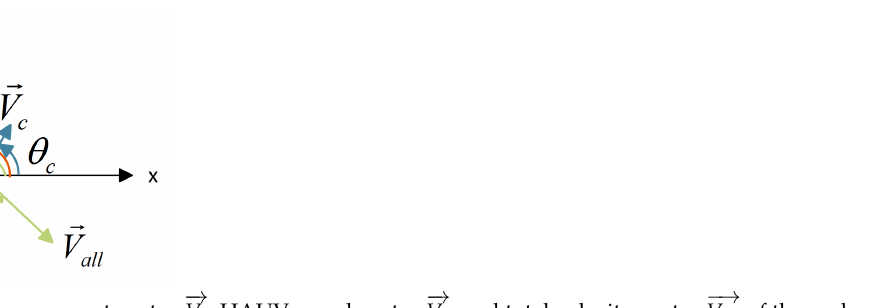
Figure 4. Ocean current vector n in the grid